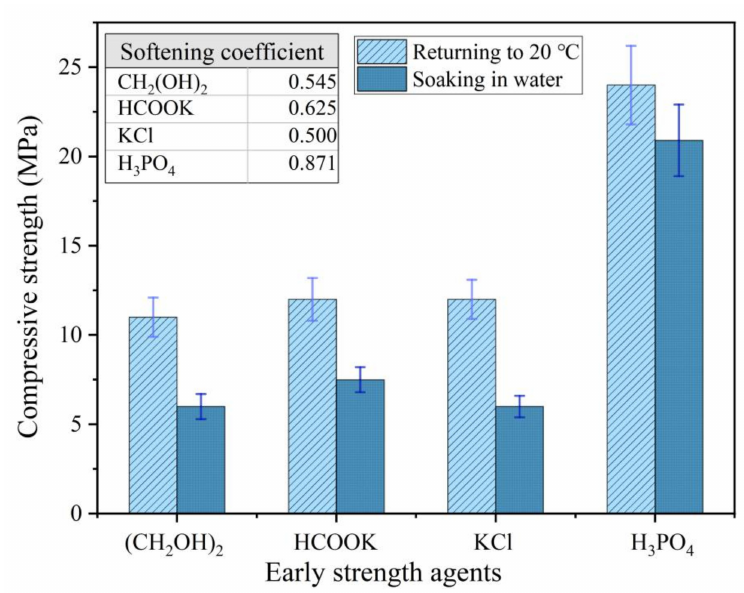
Figure 3. The strength deterioration of the MPC with early strength agents after soaking in water.